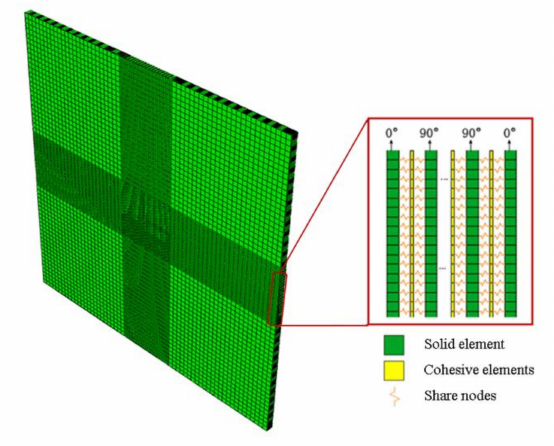
Figure 4. The model setup in the